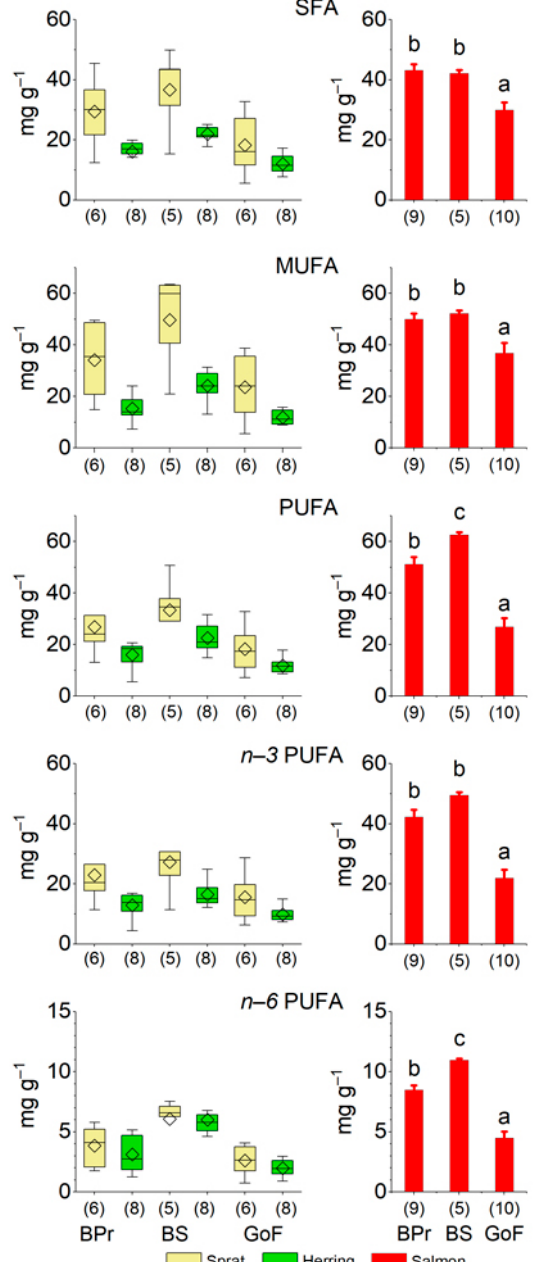
Figure 3. Concentrations of SFAs, MUFAs, PUFAs, and n − 3 and n − 6 PUFAs in the whole body of sprat ( Sprattus sprattus ) and herring ( Clupea harengus ) (with the samples of different ages in the fall and spring combined) as box plots, and in salmon ( Salmo salar ) (right column, mean ± SE, in the late fall), from the three areas of the Baltic Sea, the Baltic Proper (BPr), the Bothnian Sea (BS), and the Gulf of Finland (GoF). For further details, see the legend for Figure 2.